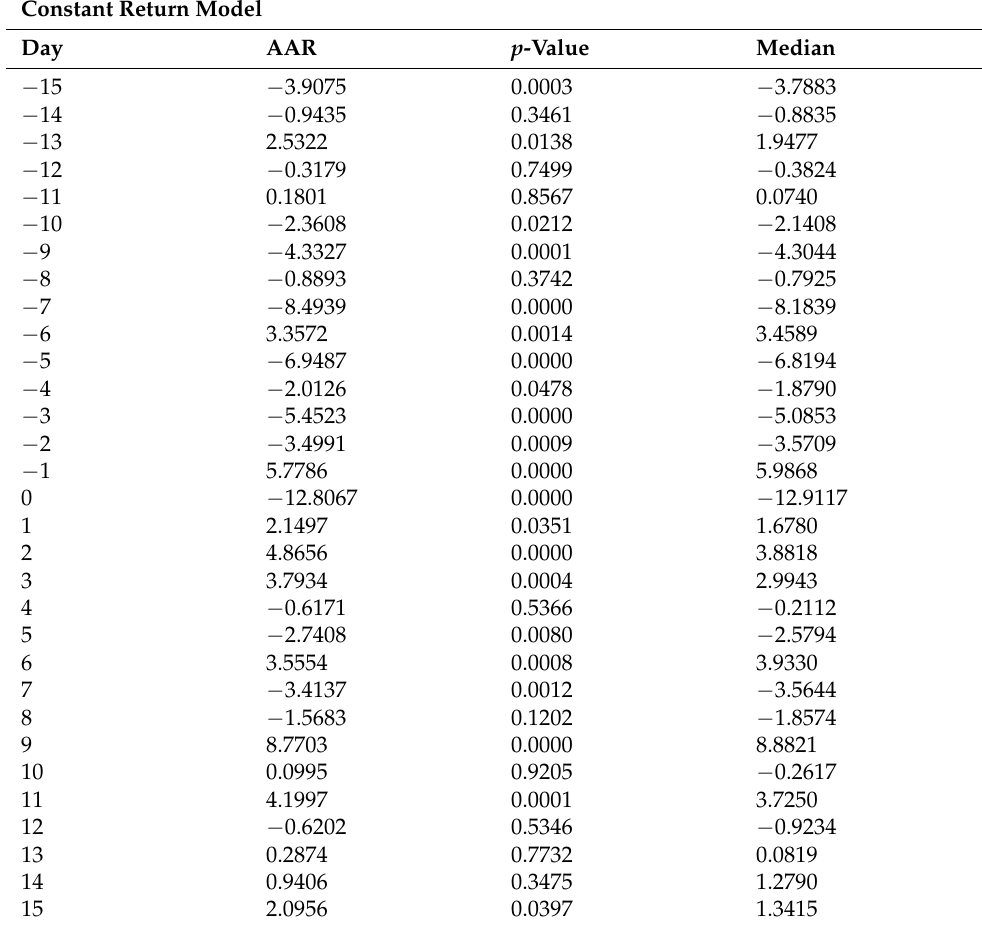
Table 1. AAR from the constant return